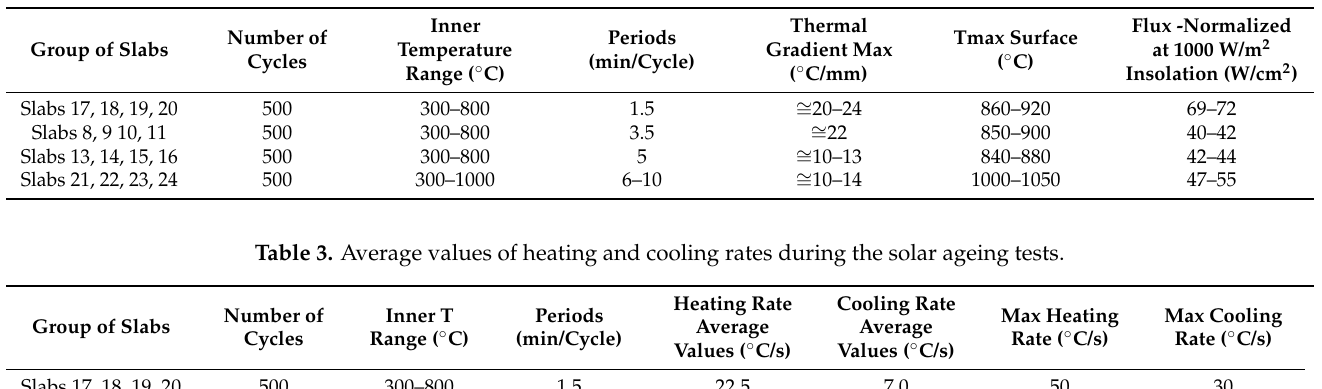
Figure 2. ( a ) Samples (50 mm × 50 mm × 5 mm) placed in horizontal position on the test bench before solar ageing testing. ( b ) Accelerated ageing test bench on test at SF40. ( c ) Slabs with thermocouples observed under concentrated solar radiation during solar ageing tests. Table 2. Parameters of the experimental ageing test conditions.